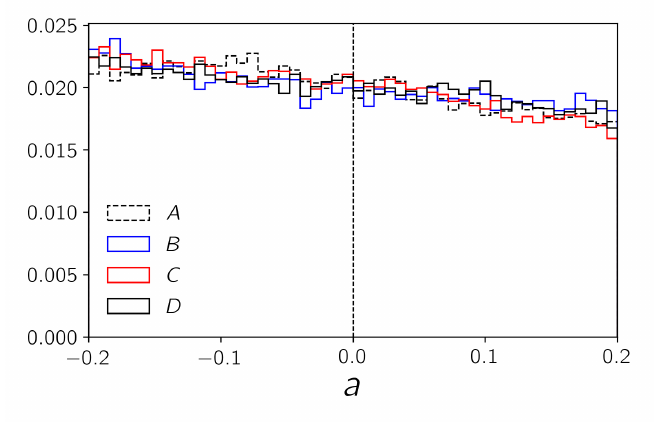
Figure 3. Marginalized posterior distributions for the dimensionless spin parameter for case A (dashed black), case B (blue), case C (red) and case D (solid black). The dashed vertical line shows the injected value of the spin parameter. Note that this distributions are statistically indistinguishable.